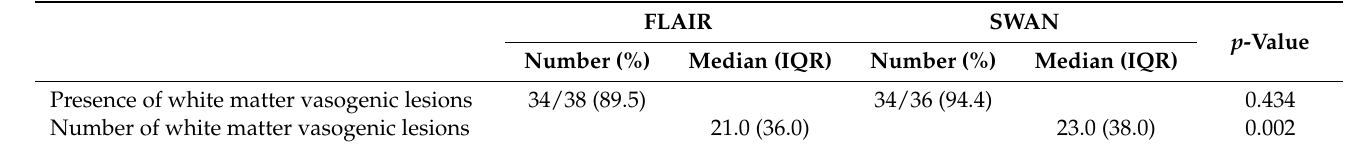
Table 6. Comparison of the occurrence and quantity of vasogenic white matter lesions in FLAIR and SWAN MRI techniques in patients with ANCA-associated vasculitis with renal